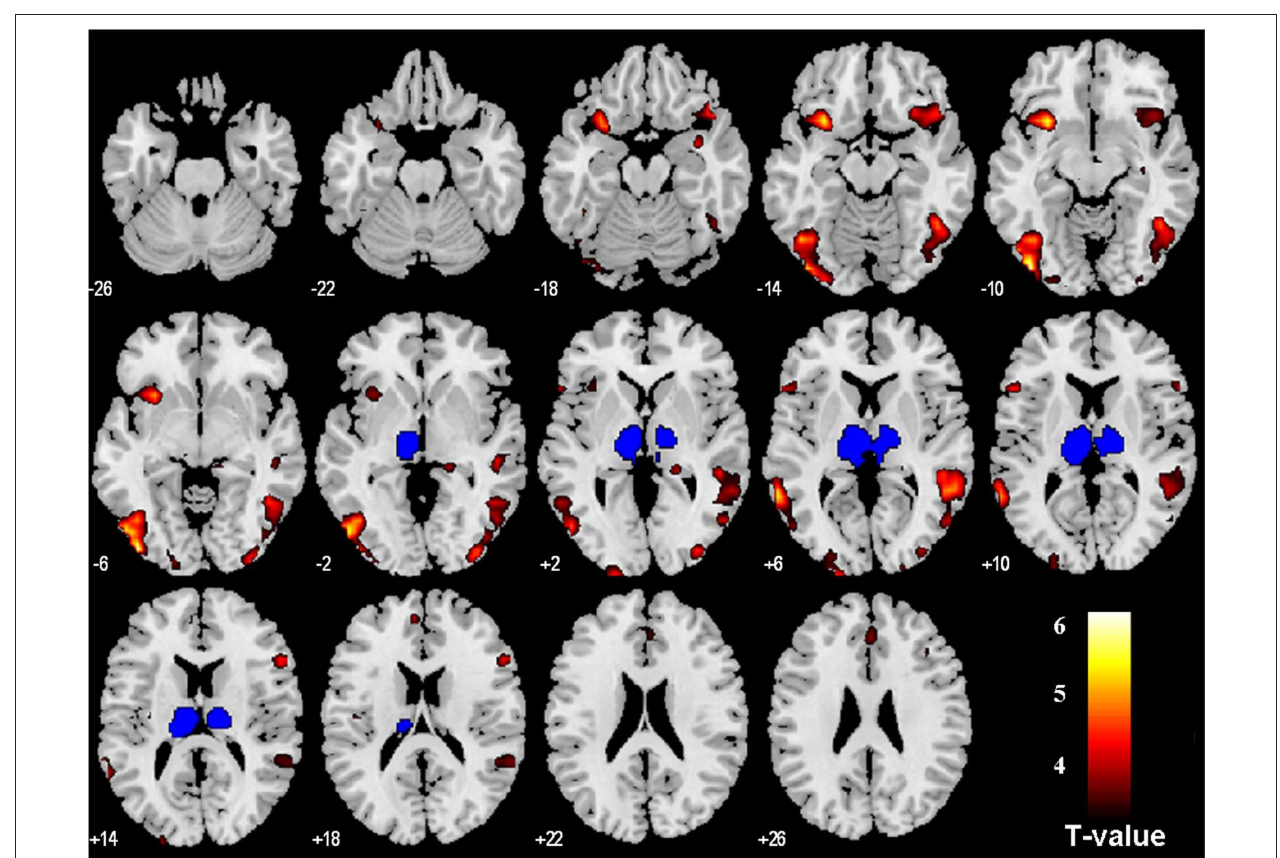
FIgure 5 | regions (in hot color) of psychophysiological interaction (PPI) with the thalamus cluster “minus the habenula” (blue), during stop error as compared to stop success; p < 0.001, uncorrected. These brain regions are